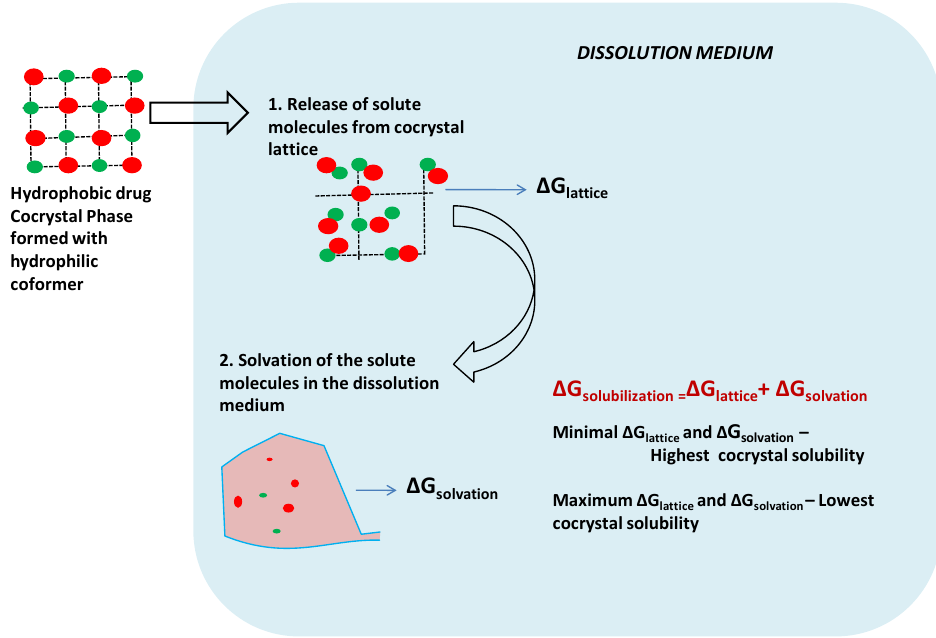
Figure 33. Schematic representation of the steps involved in solubilization of a hydrophobic drug in an aqueous medium.